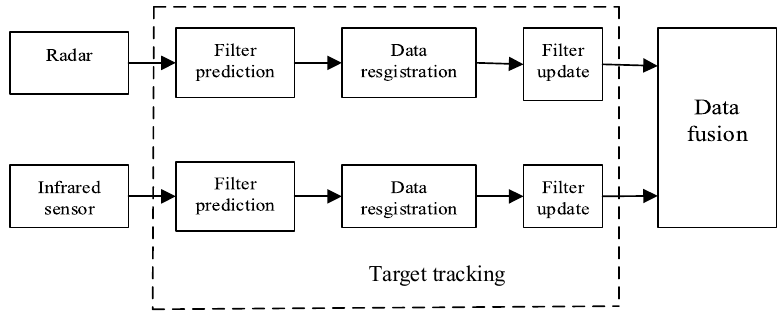
Figure 1. Traditional distributed fusion model for single target tracking.